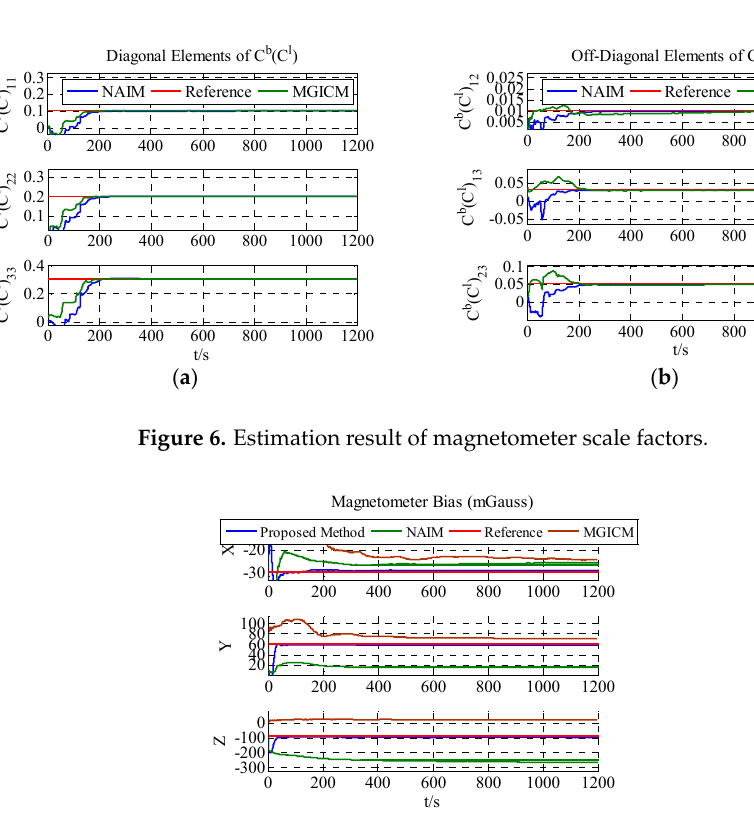
Figure 7 . Estimation result of magnetometer bias. Sensors 2018 , 18 , x FOR PEER REVIEW